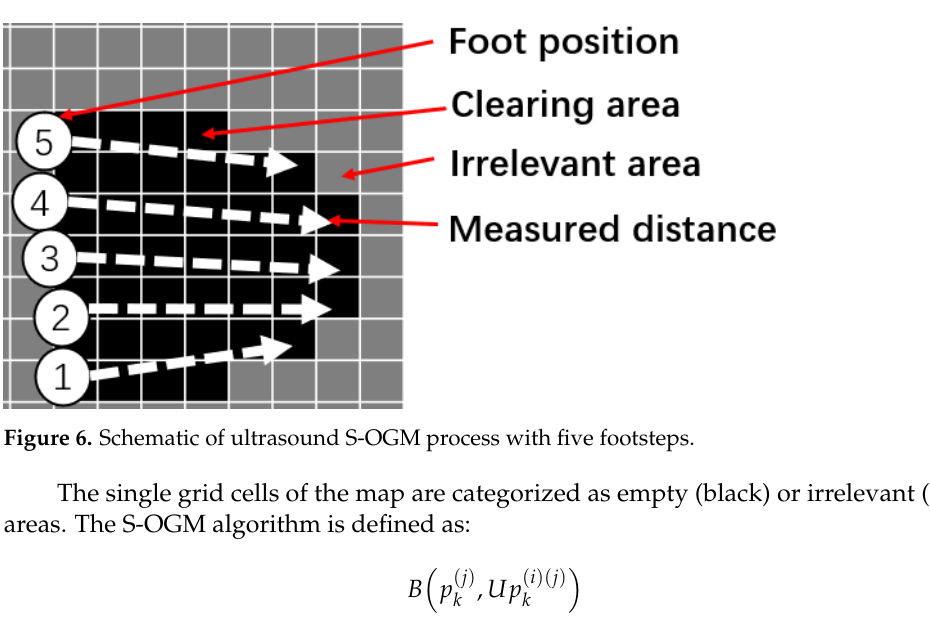
( j ) ( i )( j ) where p and Up indicate the ultrasound placement position coinciding with the foot k k position and position of the pixel at the clearing area boundary,